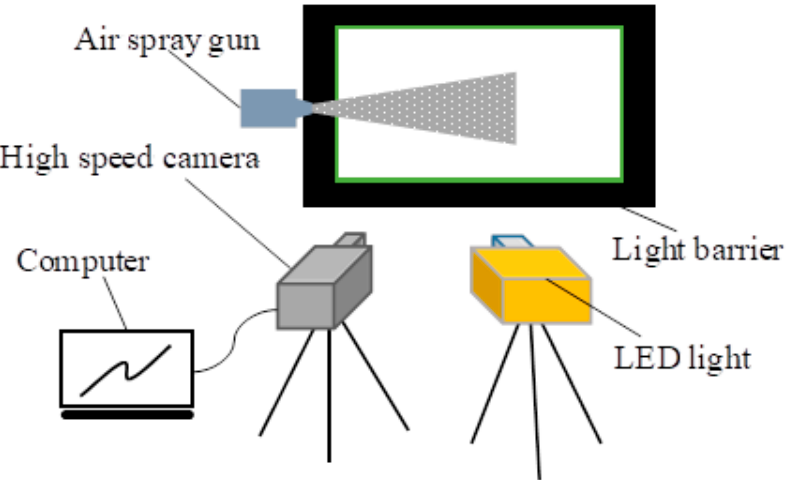
Figure 10. Paint atomization shape measurement system.